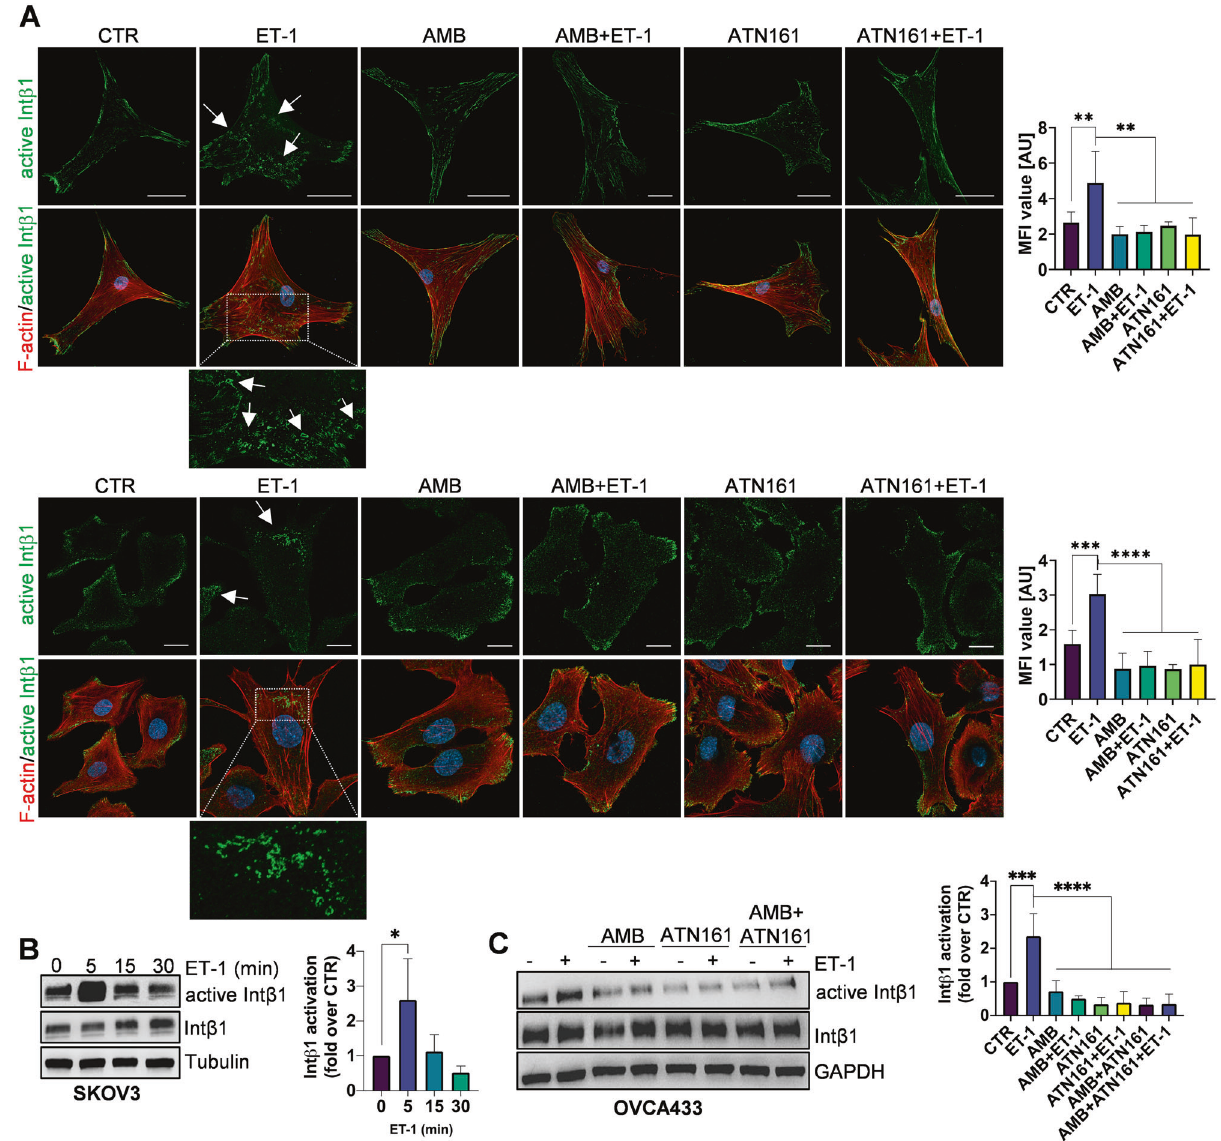
Fig. 3 ET-1/ET A R/ β -arr1 activates Int β 1 signaling. A CLSM analysis in OV.GEM#20 (upper) and SKOV3 (lower) cells, stimulated with ET-1 (100 nM) for 5 min and/or AMB (1 μ m) and/or ATN161 (1 μ m), stained for active Int β 1 (green) and F-actin (red). Nuclei are reported in blue (DAPI). For active Int β 1 a higher-power magni fi cation image of a selected ROI in ET-1-stimulated cells is shown, indicating active Int β 1 intracellular accumulation. Scale bar, 50 μ m. Histograms, mean fl uorescence intensity (MFI) of active Int β 1/cytoplasmic area means ± SD. One- way ANOVA. B Lysates of cells stimulated with ET-1 for indicated times or ( C ) with ET-1 for 5 min and/or AMB and/or ATN161 were subjected to WB for indicated proteins. Histograms, means ± SD of the average band intensity normalized to Tubulin or GAPDH (fold changes versus CTR) used as loading control; n = 3, one-way (Supplementary Fig. 4B), whereas silencing of β -arr1 inhibited the interaction of talin1 with Int β 1 (Supplementary Fig. 4C). Moreover,